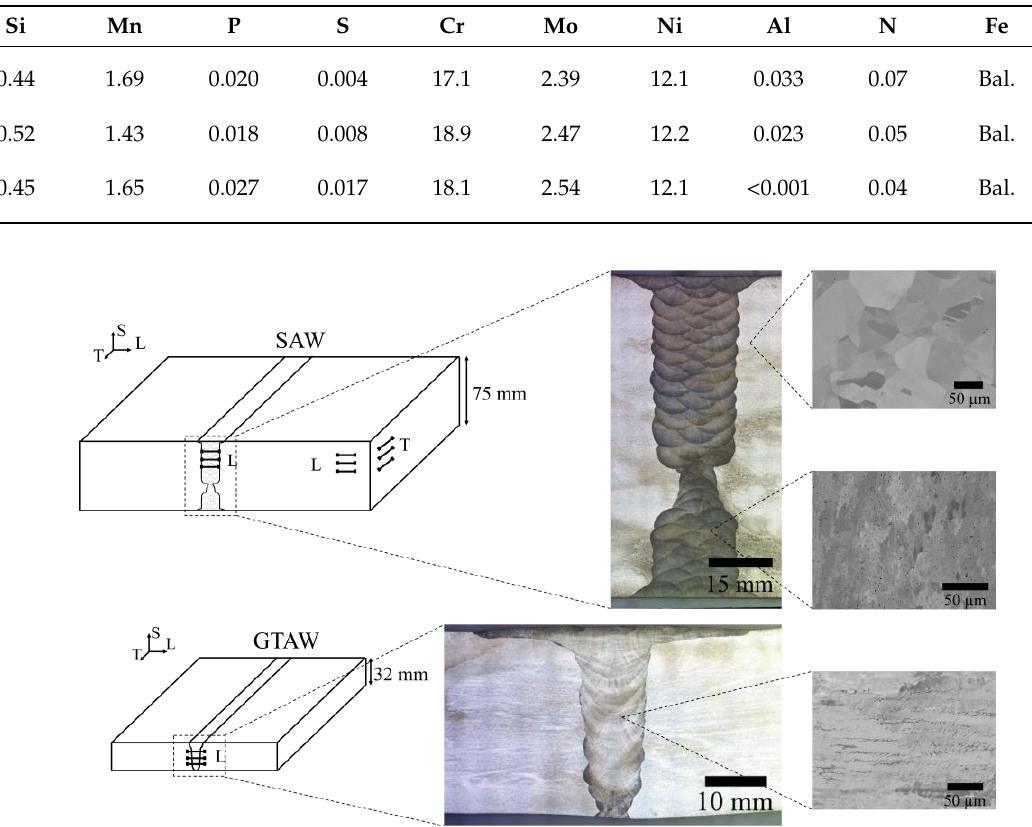
Figure 1. Schematic drawing of the 75 mm thick SAW plate and the 32 mm thick GTAW plate ( left ) with the optical image of the macrograph etched by Carpenter 300 series etchant ( middle ) and SEM image of microstructures ( right ). The locations and orientations of extracted tensile samples are indicated. The relative sizes of the samples with respect to the size of the weld and plate thickness are correct. Table 2. Test matrix of SSRT tests presented in this work.